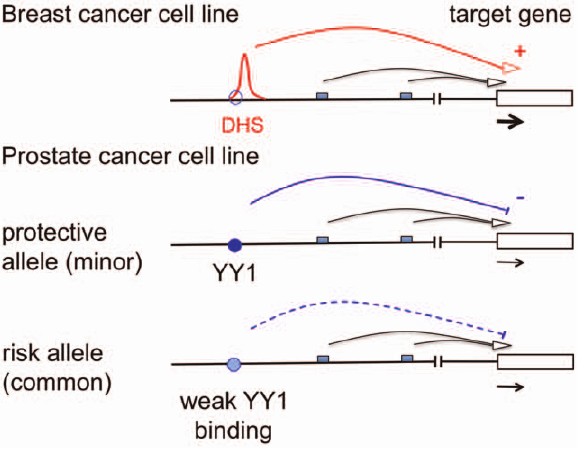
Figure 5. Schematic representation of the mode of action of rs378854. In a breast cancer cell line rs378854 is not bound by YY1 (site shown as empty blue circle) and the DHS present in this region is likely to act as a transcriptional regulator. In contrast, in a prostate cancer cell line YY1 binds (filled blue circle) and represses transcription of a target gene. The level of repression is influenced by the presence of the SNP in the YY1 binding site. Small boxes represent multiple other regulatory elements known to exist in the